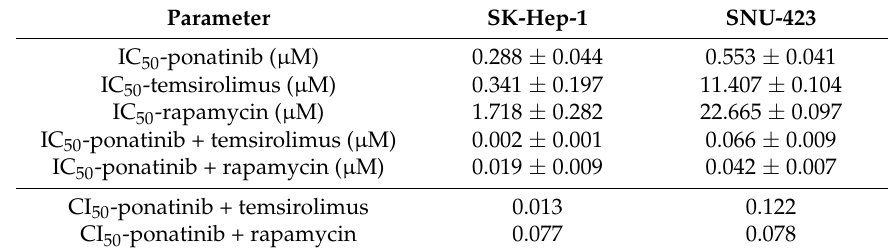
Table 3. Dose-response profiles of ponatinib + temsirolimus and ponatinib + rapamycin drug combinations.